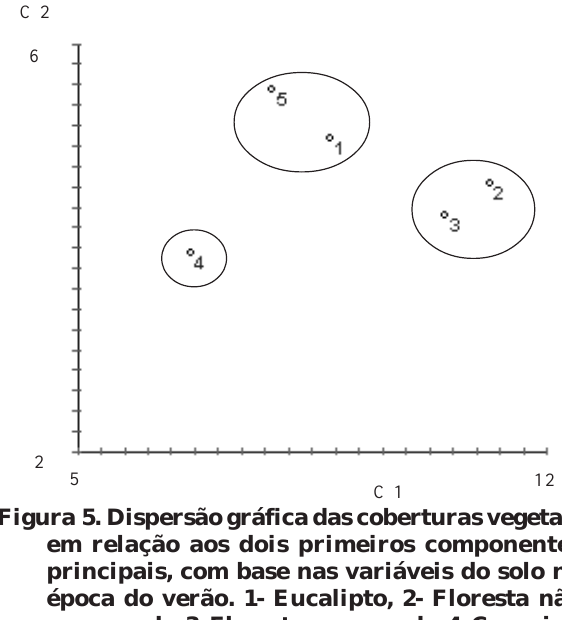
Figura 5. Dispersão gráfica das coberturas vegetais em relação aos dois primeiros componentes principais, com base nas variáveis do solo na época do verão. 1- Eucalipto, 2- Floresta não preservada, 3- Floresta preservada, 4- Capoeira, 5- Pasto. C1- componente principal 1, C2- componente principal 2. 1- Eucalipto,